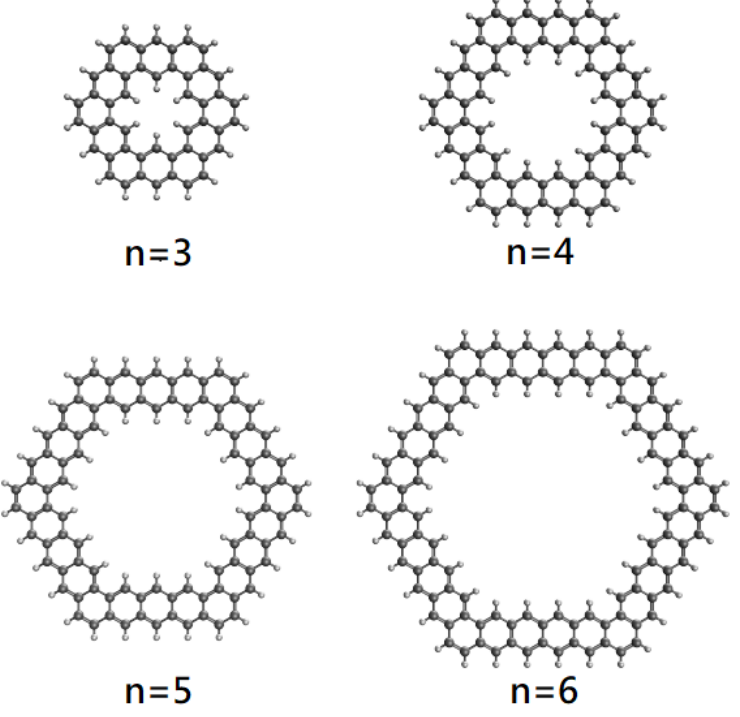
Figure 1. Geometry of n -HGQR, consisting of n aromatic rings fused together at each